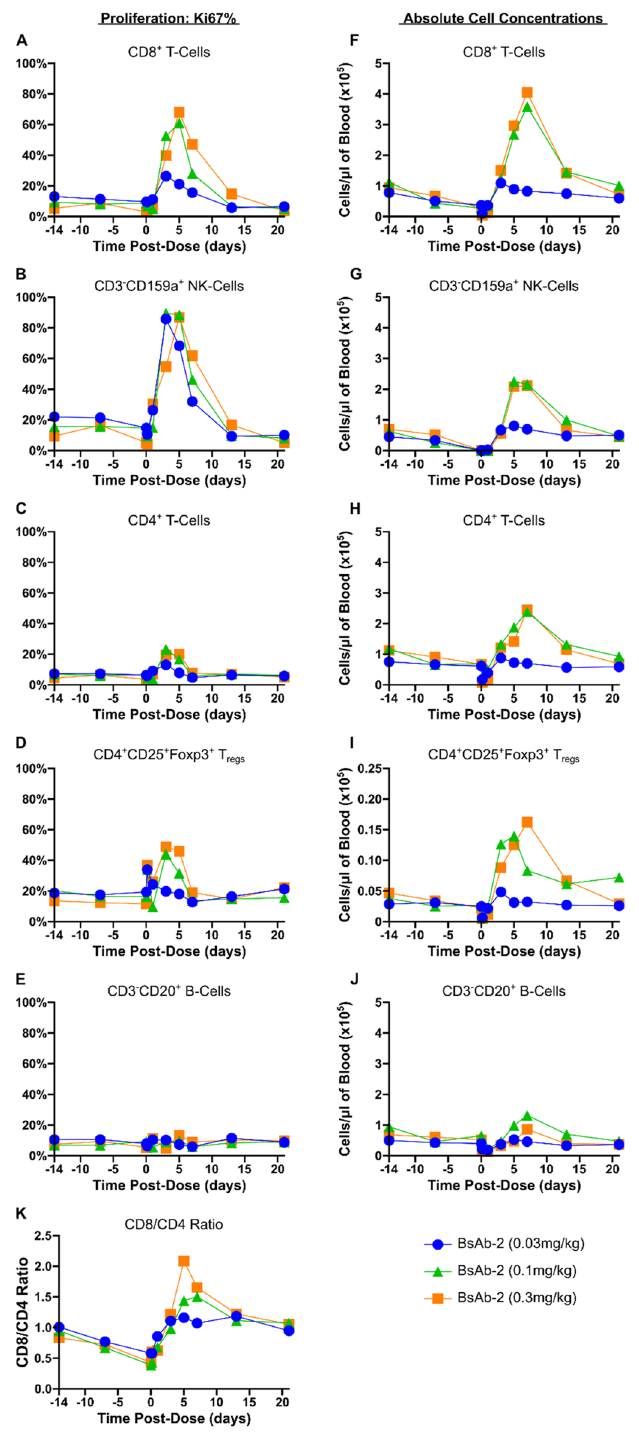
Figure 5. BsAb-2 induces dose-dependent lymphocyte proliferation in cynomolgus monkeys. Healthy cynomolgus monkeys (n = 2 per treatment group [1 male + 1 female]) were treated once with 0.03, 0.1, or 0.3 mg/kg body weight of BsAb-2 by intravenous injection. Peripheral blood was collected at 10 time points and cellular compartment was analyzed by flow cytometry. ( A to E ) Percentages of Ki67-expressing CD8 + T-cells ( A ), CD3 - CD159a + NK-cells ( B ), CD4 + T-cells ( C ), CD4 + CD25 + FoxP3 + T regs ( D ), and CD3 - CD20 + B-cells ( E ). ( F to J ) Absolute cell numbers of CD8 + T-cells ( F ), CD3 - CD159a + NK-cells ( G ), CD4 + T-cells ( H ), CD4 + CD25 + FoxP3 + T regs ( I ), and CD3 - CD20 + B-cells ( J ). Cell numbers determined using BD TruCount beads. ( K ) Ratio of CD8 + T-cells to CD4 + T-cells in cynomolgus peripheral blood.Data shown is the mean of the two